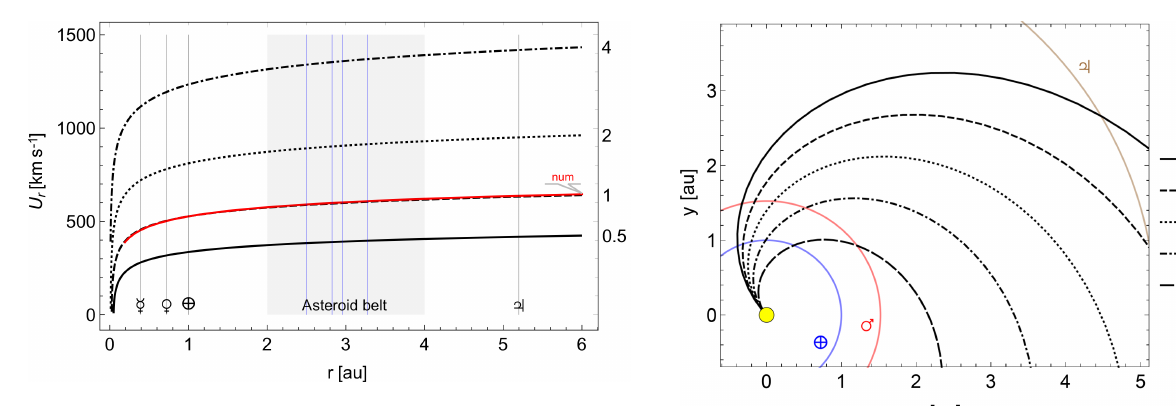
Figure 1. Radial solution of the solar wind U r for different temper- atures in megakelvin (right frame ticks). Vertical lines indicate the position of the planets; the dark-shaded region covers the region of main belt asteroids of the solar system, where blue lines mark the position of mean motion resonances of asteroids with planet Jupiter.